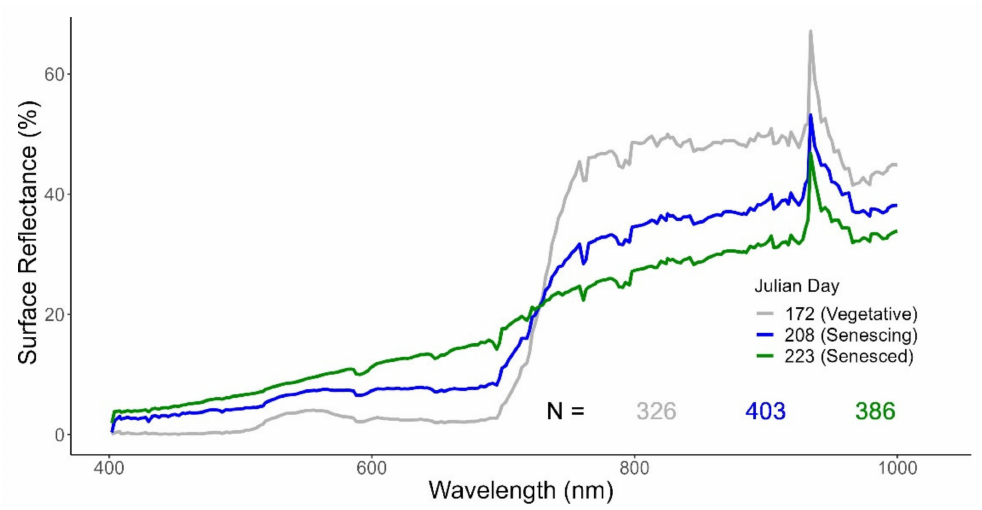
Figure 7. DESIS Corn Spectra for the year 2019 (wet year). DESIS corn spectra on Julian Days 172 (June), 208 (July), and 223 (August) in Oklahoma, USA.